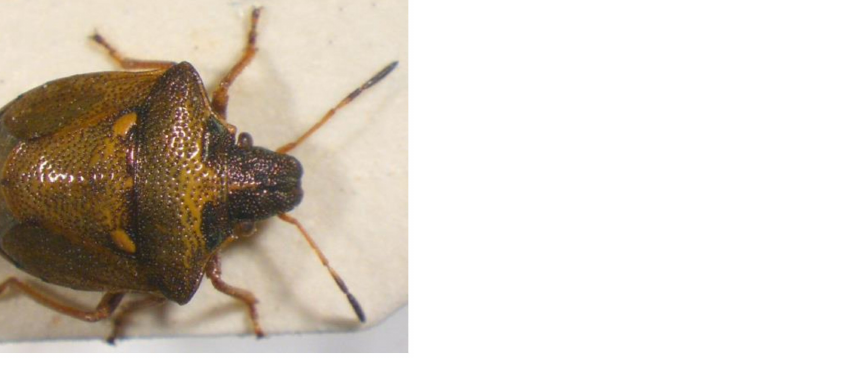
Figure 9. Eysarcoris aeneus (Collector S. Drosopoulos, Sidironero, 23.V.1983, posited in S. Drosopoulos historical collection. Photo A. Tsagkarakis,